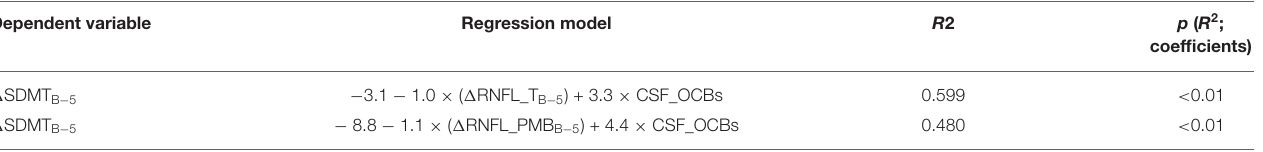
TABLE 5 | Regression models that explain the cognitive decline over 5 years in patients with MS. Dependent variable Regression